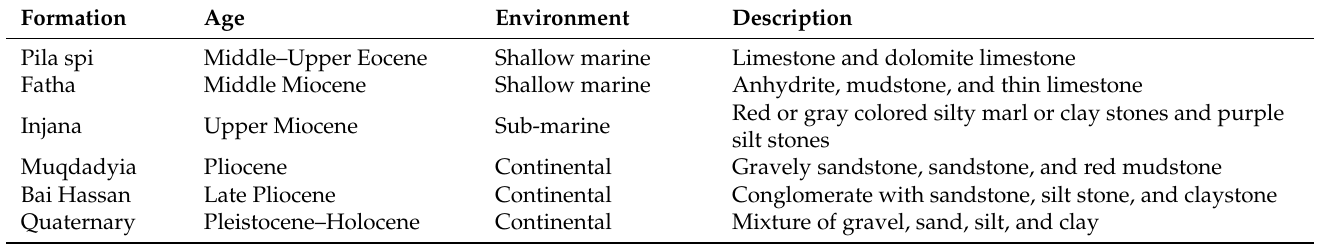
Table 1. A brief description of the exposed geological formations in the study area (After [31]).